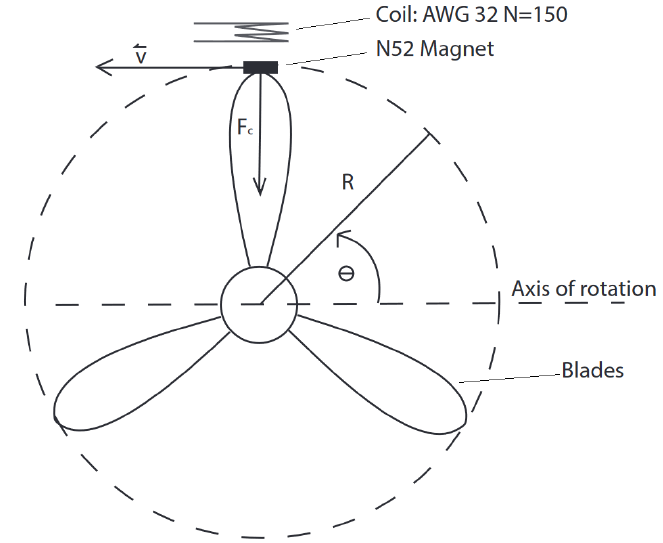
Figure 8. Reference turbine-style harvester with magnets attached to the tips (max radius) of the blades and coil attached to the stationary surface, similar to the designs presented by [22,30].